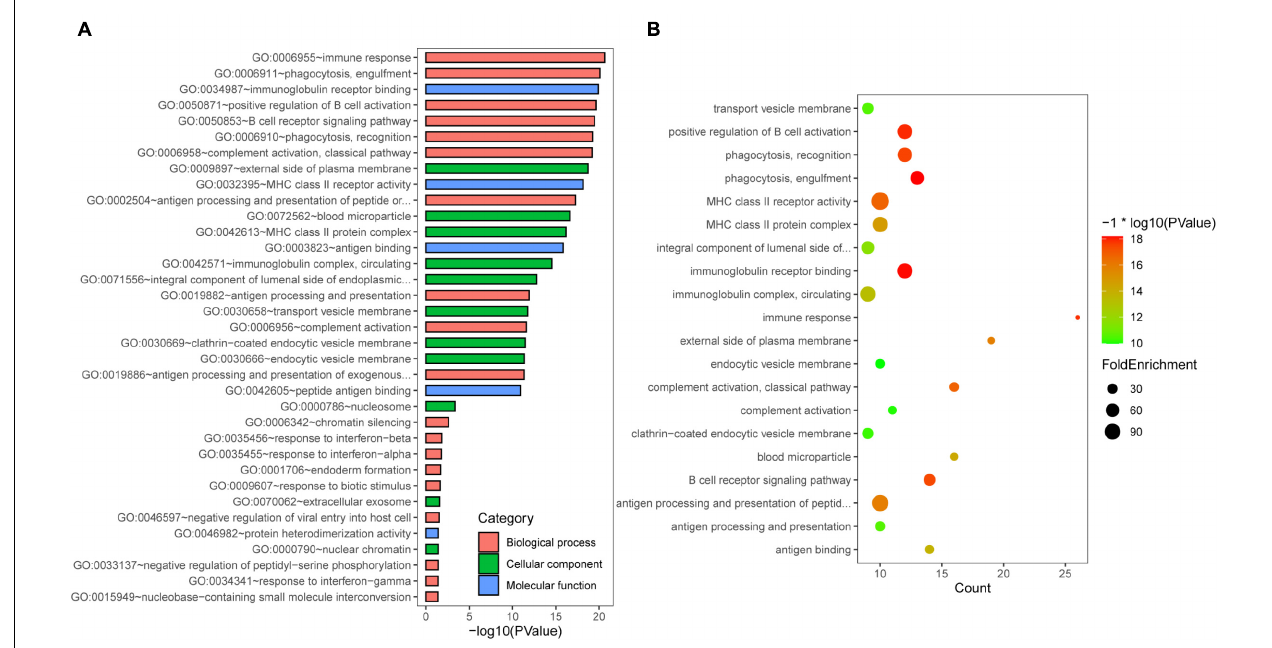
FIGURE 2 | Gene Ontology (GO) enrichment analysis. (A) GO analysis of DEGs consisting of biological process (BP), molecular function (MF), and cellular component (CC). (B) The bubble map of pathway enrichment analysis of all DEGs.